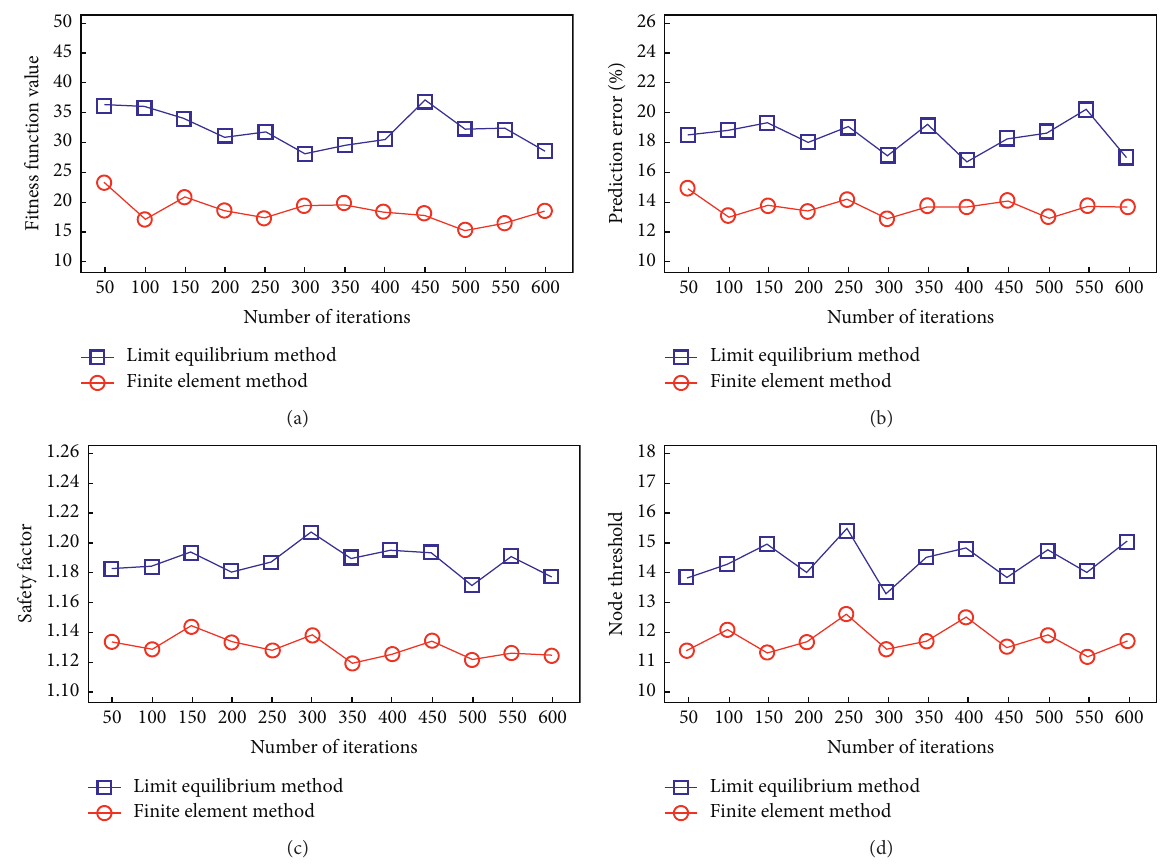
Figure 6: Fitness function value (a), prediction error (b), safety factor (c), and node threshold (d) of the limit equilibrium method and finite element method in mine rock slope stability rating.